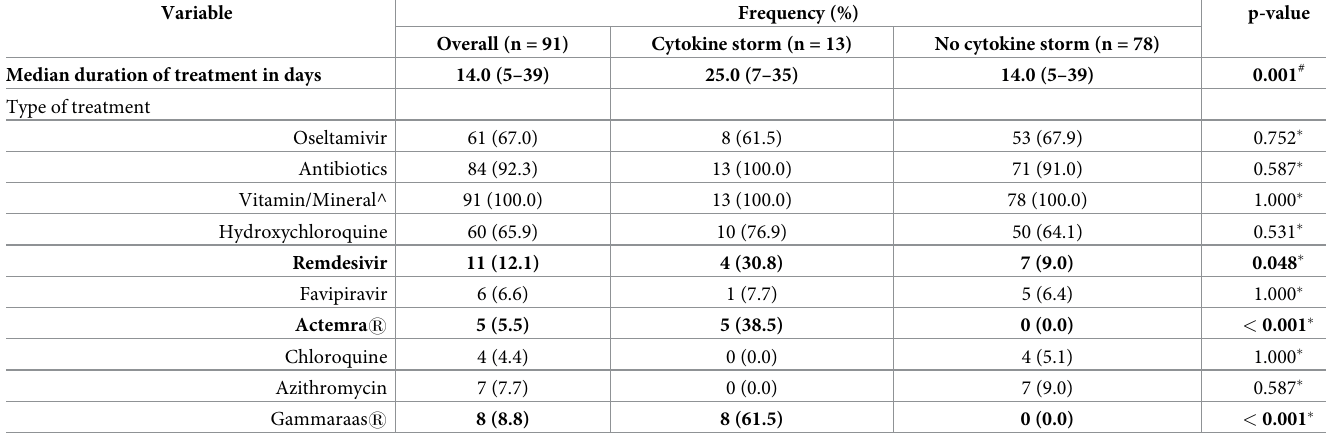
Table 2. Correlation between cytokine storm experienced with duration and type of